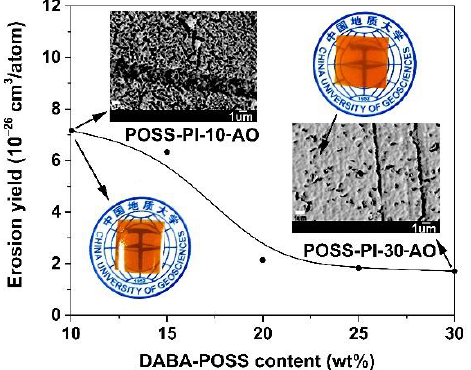
Figure 10. AO erosion yields as a function of DABA-POSS contents for the POSS-PI composite films (Insert: Appearance and field emission scanning electron microscopy (FE-SEM) images of POSS-PI-10-AO and POSS-PI-30-AO exposure to 2.51 × 10 21 atom/cm 2 AO attack, respectively).